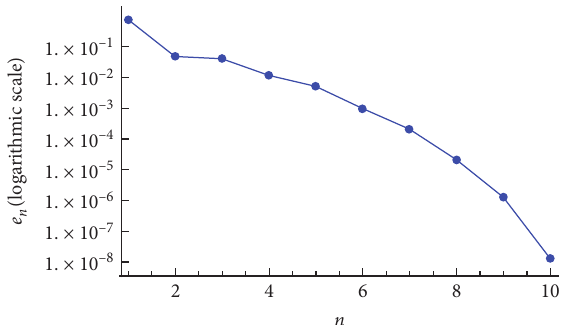
Figure 10: e n on logarithmic scale for